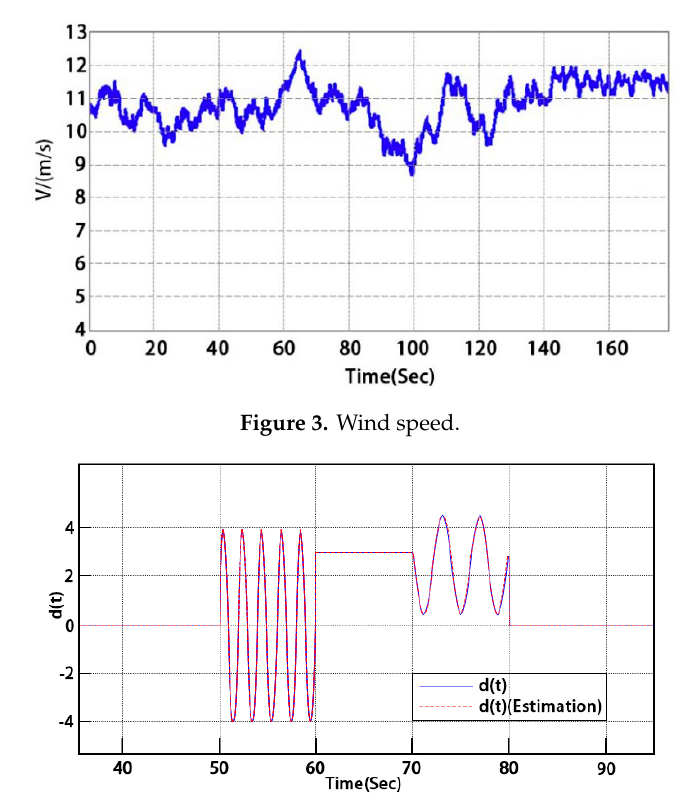
Figure 4. Actuator faults signal d ( t ) and its estimate.